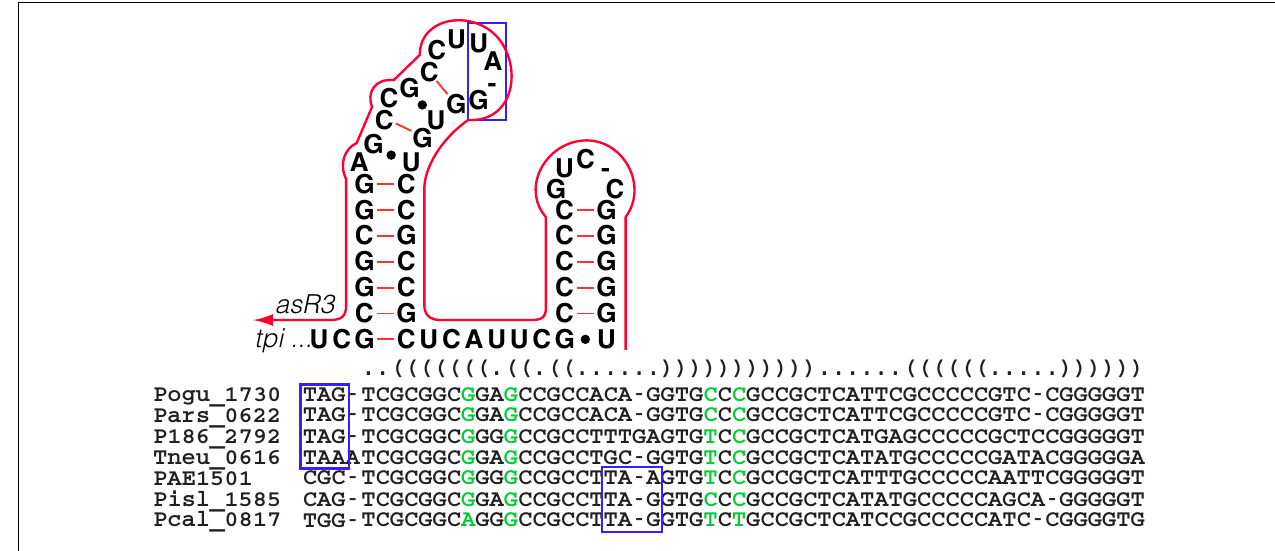
Pyrobaculum sp.1860 (P186_2792), and P. neutrophilum (Tneu_0616), the stop codon is immediately upstream of the tpi-element. asR3 (red line) is encoded on the opposite strand, and has potential to compete/interfere with the tpi-element secondary structure.The genomic alignment of the 3 (cid:48) portion of tpi and 3 (cid:48) UTR is shown with the consensus secondary structure (nested parentheses). Base paired columns with one or more substitutions that maintain secondary structure are highlighted